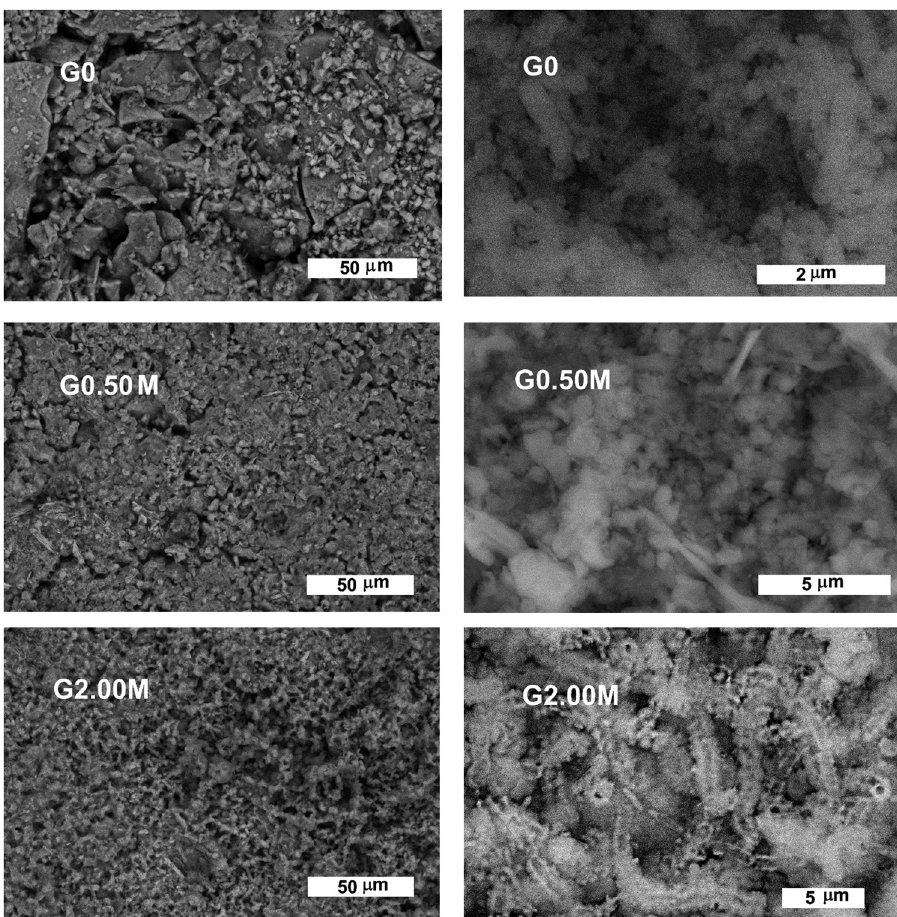
Figure 8: SEM micrographs of the G0, G0.50M and G2.00M glasses sintered at 1,100°C/2 h and soaked in SBF for a